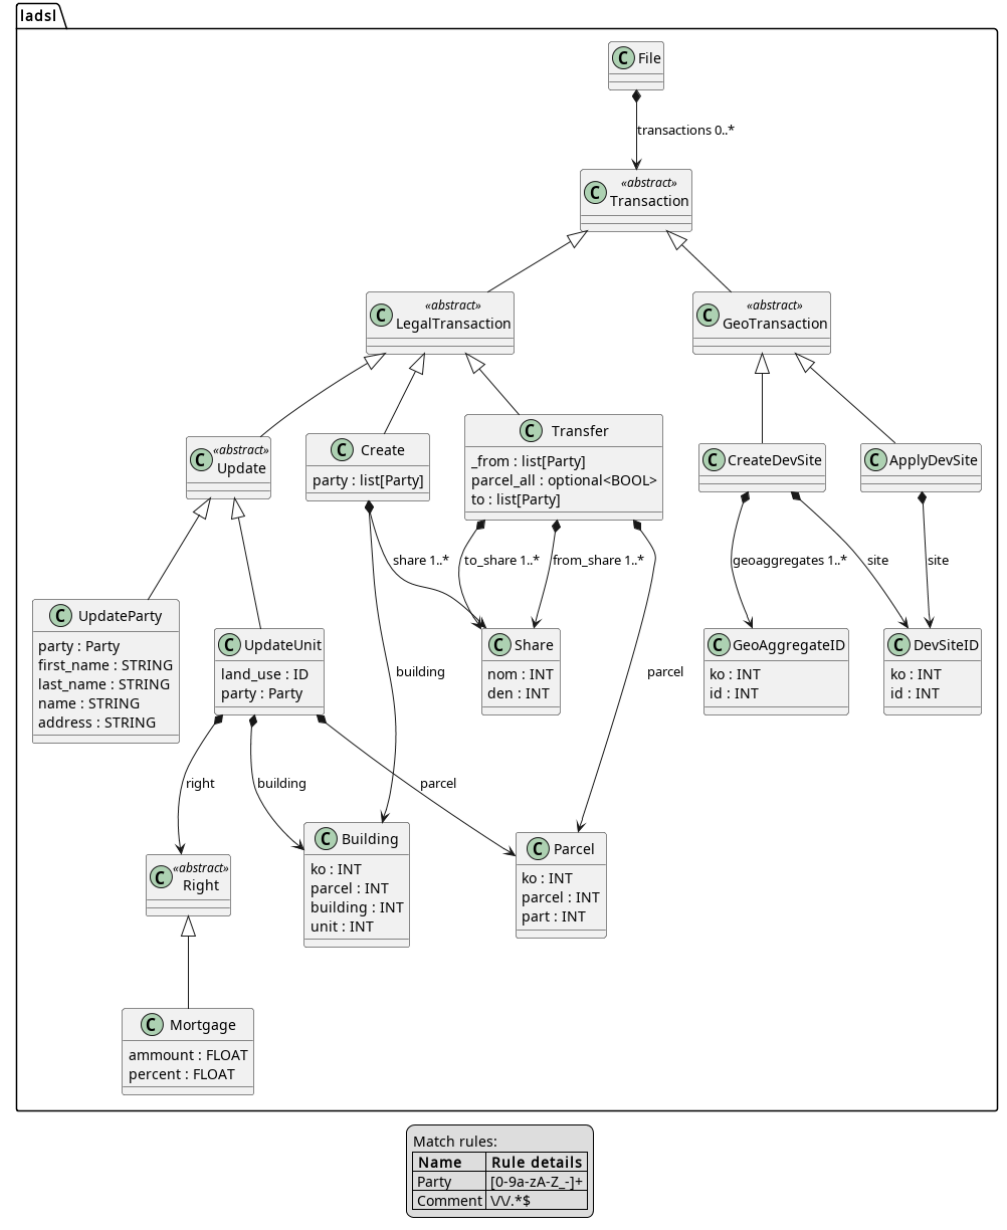
Figure 7. Meta-model of DSL for LA. In Listing 7, party11 and party12 are selling parcel 23/101 with the share in the ownership of 1/2 and 1/2, to party21 and party22 in the shares 1/3 and 2/3, respectively. The DSL for this transfer is written in lines 31 through